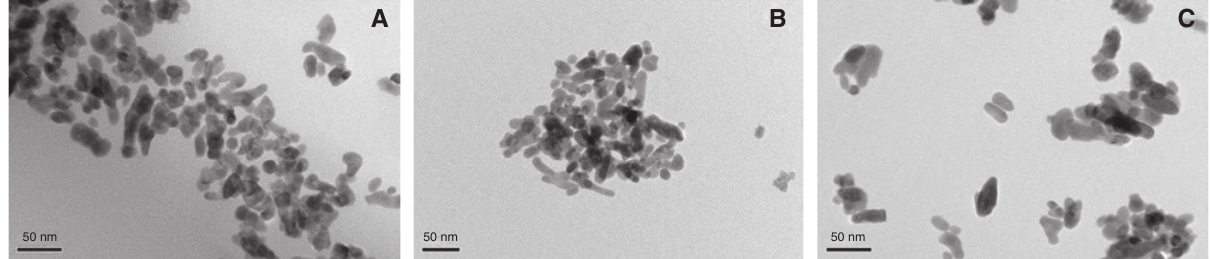
O nanoparticles prepared by annealing in air with the different ratios of nitrate to ammonium bicarbonate: (A) 1:1, Figure 7: TEM of In 2 3 (B) 1:1.5, (C) 1:2.